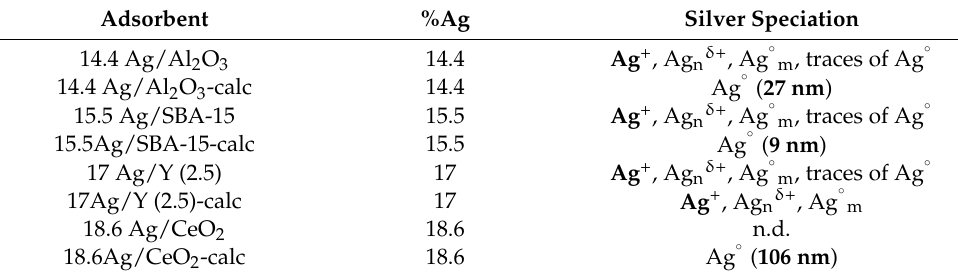
Table 1. Main physiochemical characteristics of the investigated